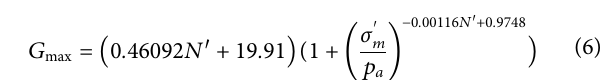
FIGURE 10 | G 0 and n for specimens with different SPT- N ’ value (different weathered degrees).